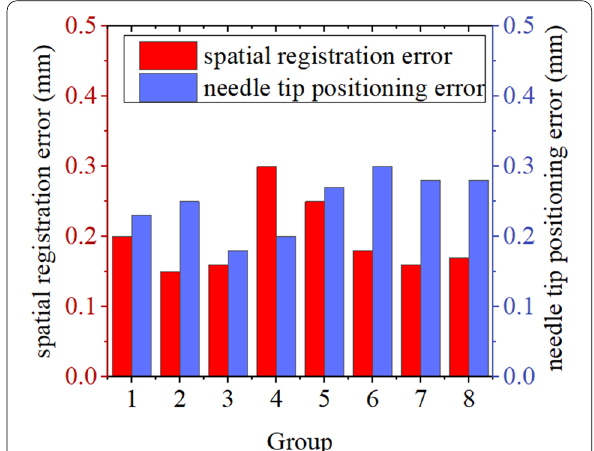
Figure 10 The error of spatial registration and needle tip positioning